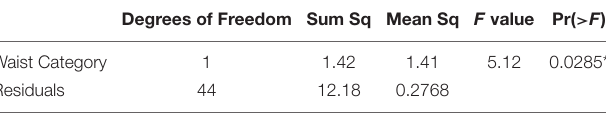
TABLE 2 | Result summary of the ANOVA model for premenstrual food cravings.